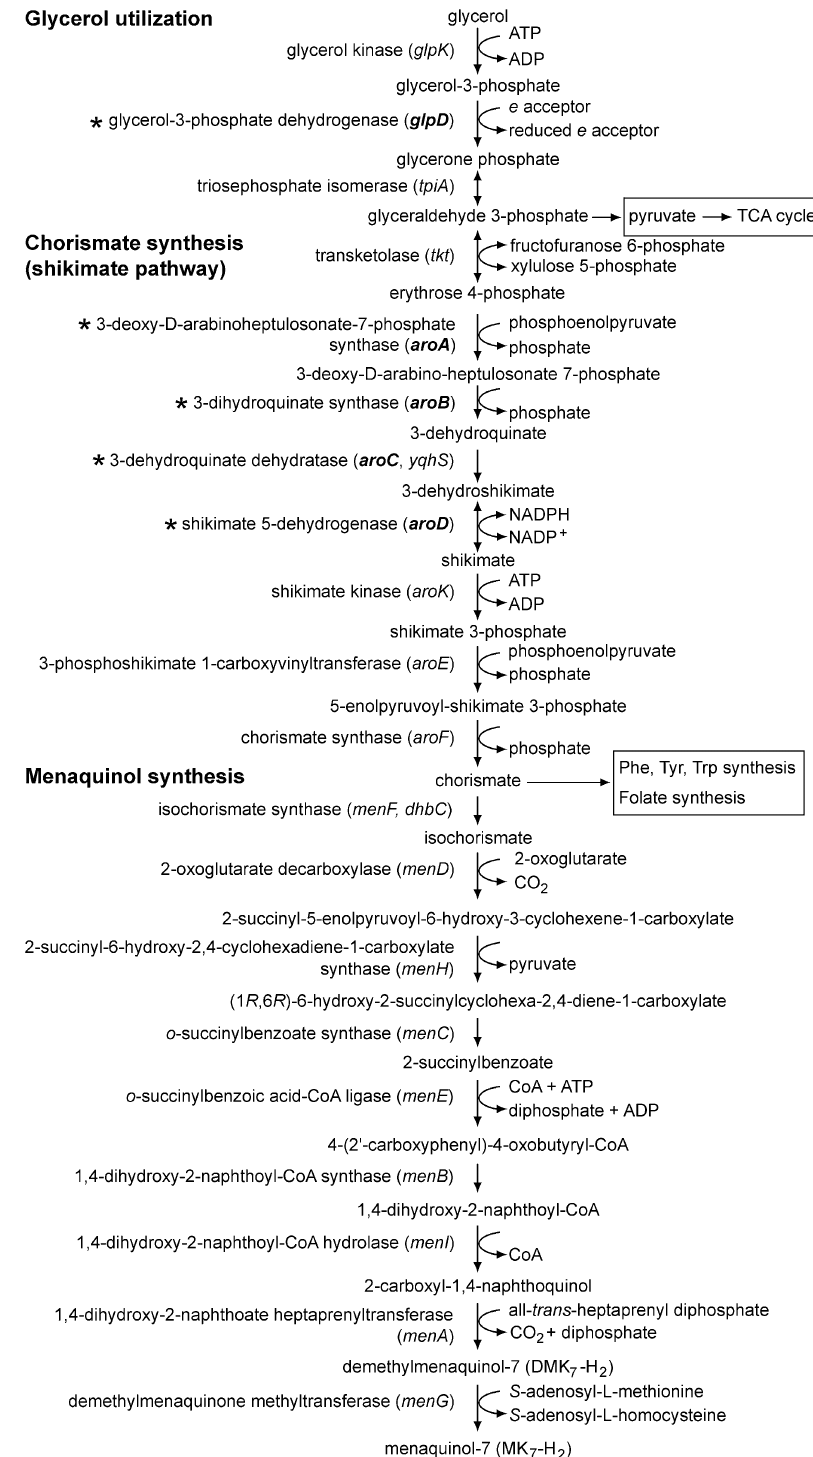
Figure 2. Glycerol utilization and synthesis of shikimate, chorismate, and menaquinol in B. subtilis (based on BsubCyc https ://bsubc yc.org/ 24 and 21,23 ); aroA-D and glpD are indicated by an asterisk